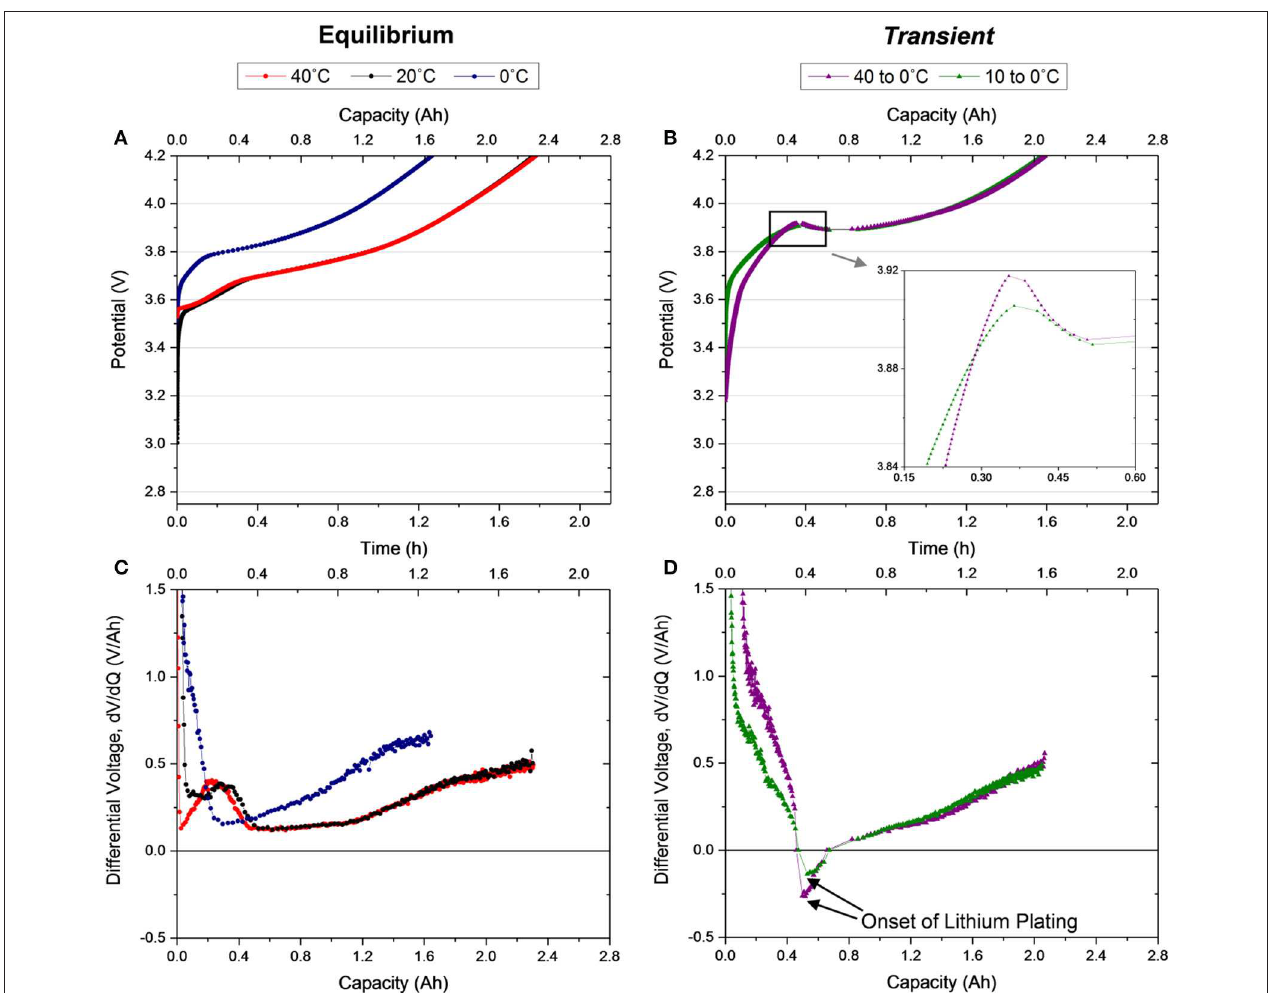
FIGURE 2 | Voltage profiles for the first C/2 galvanostatic charge of (A) Equilibrium 40, 20, and 0 ◦ C cells after a 1.5h rest, (B) Transient 40 to 0 ◦ C and 10 to 0 ◦ C cells after no rest, and their corresponding differential voltage (C,D) ,